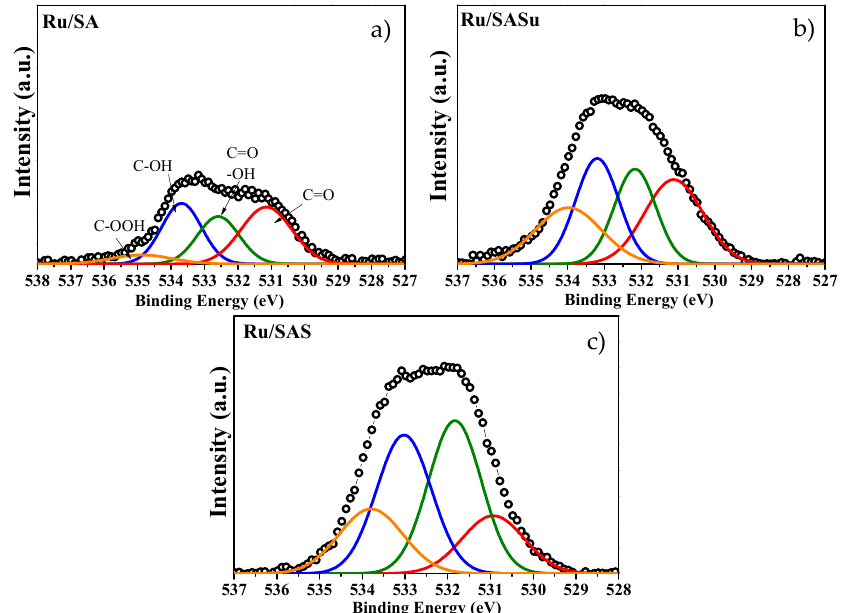
Figure 4. O 1s XPS spectra of: ( a ) Ru / SA, ( b ) Ru / SASu and ( c ) Ru / SAS. The code color indicated is the same in Figures ( a ), ( b ) and ( c ).